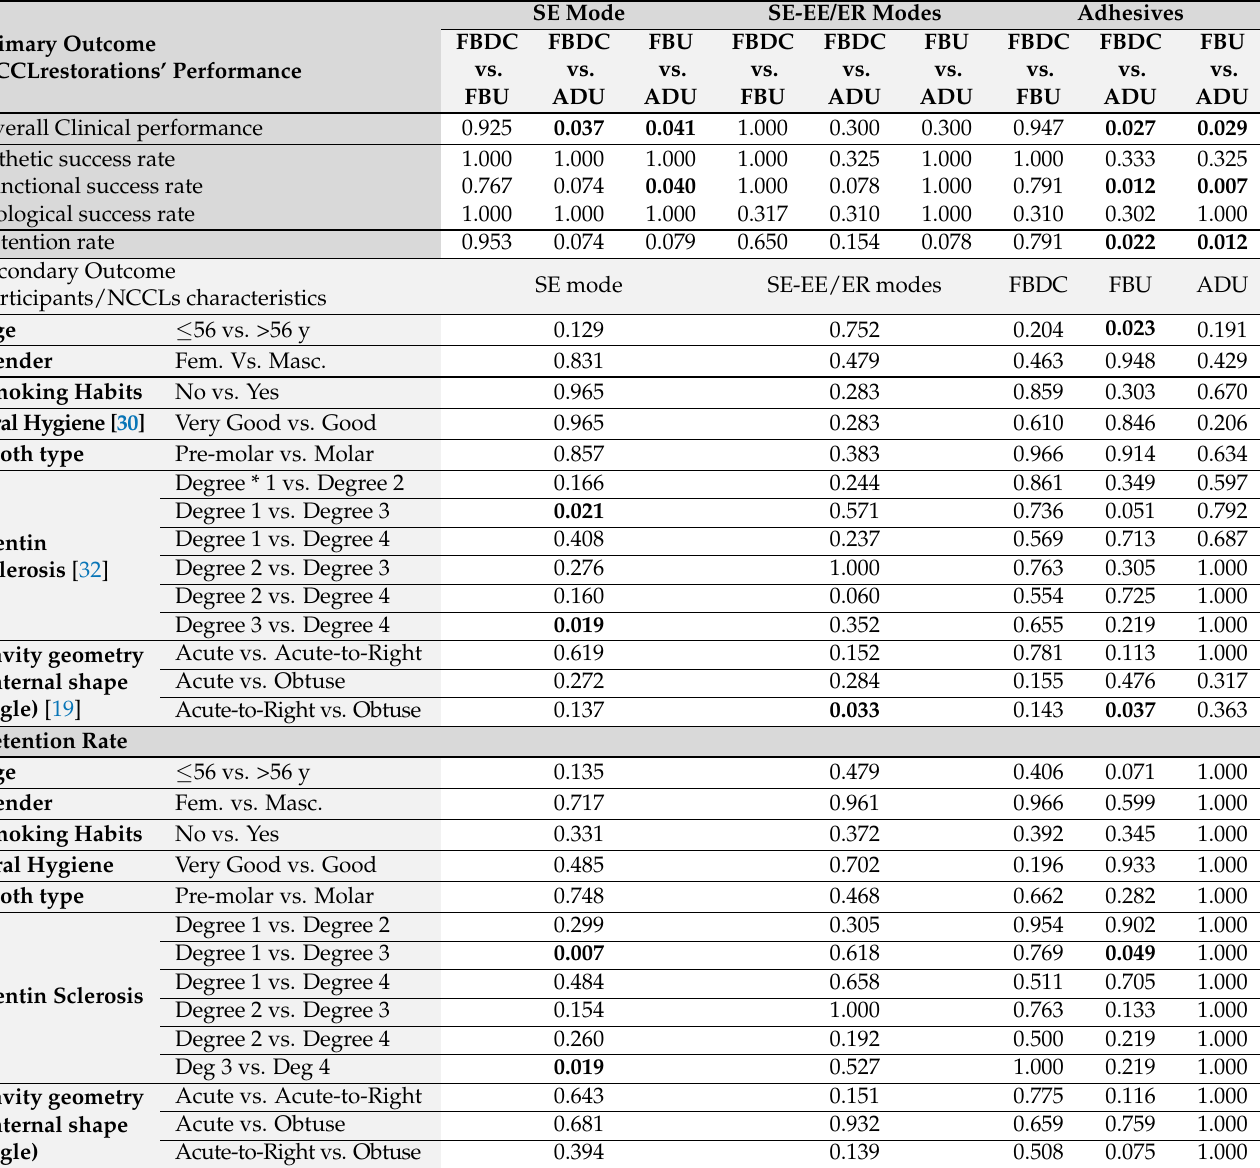
Table 4. P value of the NCCLs group’ restorations pairwise comparisons (log-rank test, Mantel-Cox) for the clinical performance, clinical properties success and retention rates, and participants/NCCLs’ baseline features comparison regarding the overall clinical performance and the retention rates, by FDI criteria, at the 2-year recall